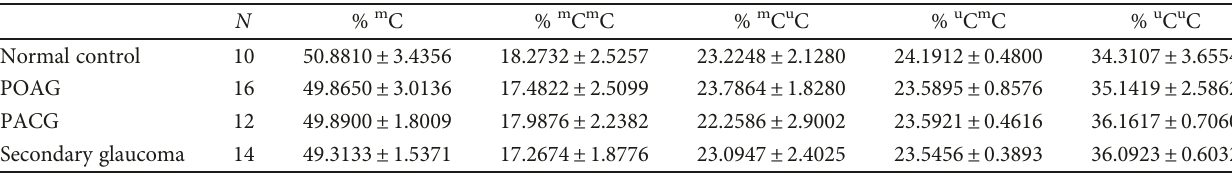
Table 2: LINE-1 methylation levels in glaucoma eyes and control eyes.